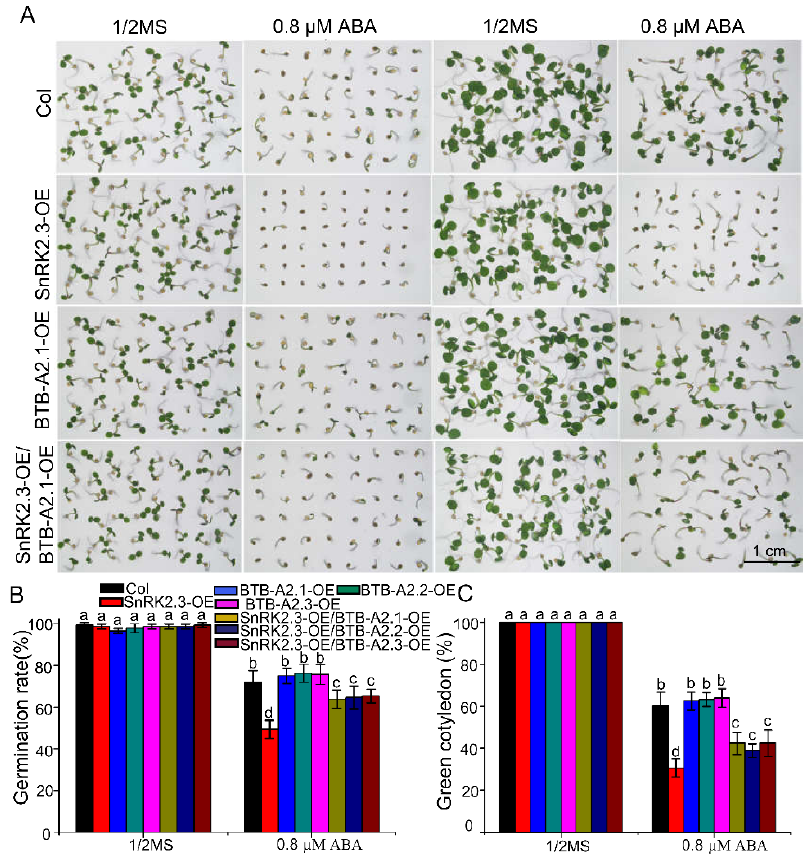
Figure 7. Overexpression of BTB-A2.1 inhibits the ABA-hypersensitive phenotypes of lines overexpressing SnRK2.3 . ( A ) The seeds of the WT, SnRK2.3 -OE line, BTB-A2.1 -OE line, and SnRK2.3 -OE line in the BTB-A2.1 -OE background were germinated in 1/2 MS medium with or without 0.8 μM ABA. The images were taken after three days (first two columns) and five days (last two columns) of stratification; ( B ) The statistics of the germination rate; ( C ) The statistics of the green cotyledon rate. About 150 seeds of each line were used in each experiment, and each assay was repeated three times. Values labeled with different letters indicate a significant difference ( p < 0.05).